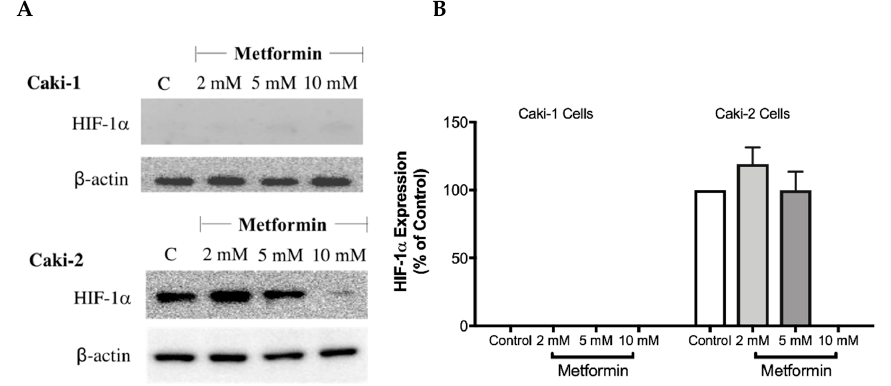
Figure 5. Metformin reduced the expression of HIF-1 α in Caki-2 renal cancer cells. ( A ) Shows a Western blot analysis of HIF-1 α in Caki-1 and Caki-2 cells incubated in the absence (control) or presence of metformin (2, 5, and 10 mM). Images are representative of three independent experiments per group. ( B ) Histograms represent pooled densitometry data normalized to β -actin expressed as the percentage of control. Data are presented as mean ±